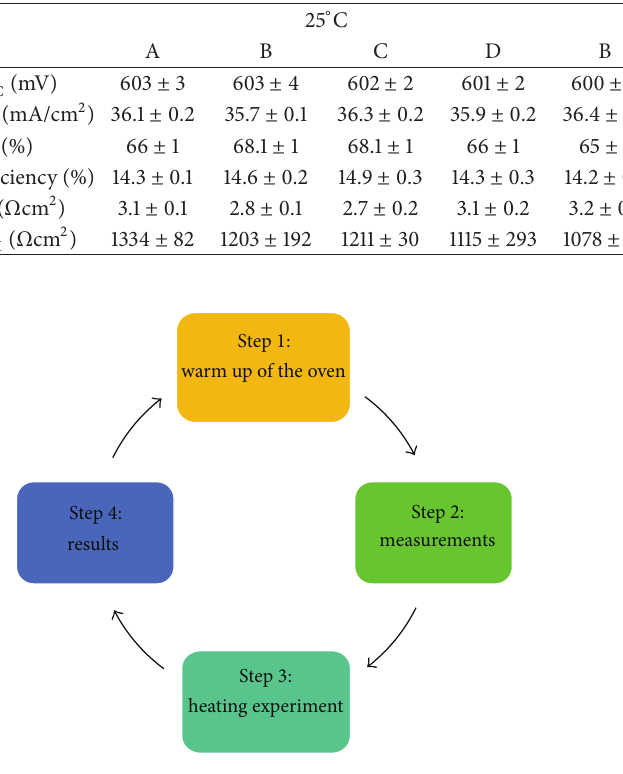
Figure 2: Cyclic steps for the heating experiments.